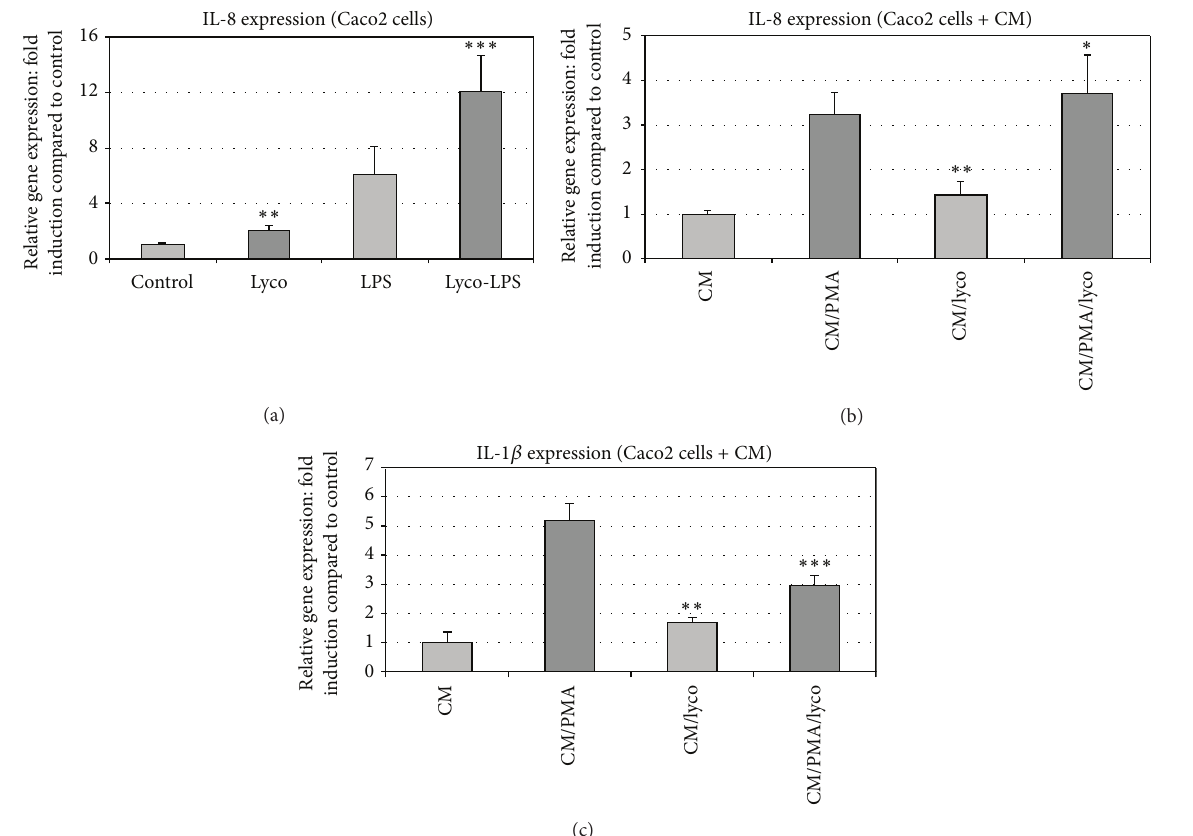
Figure 5: Lycopene-induced modulation of IL-8 and IL-1 gene expression in Caco2 cells. (a) Lycopene induced upregulation of basal and LPS- induced IL-8 gene expression in Caco2 cells. IL-8 gene expression was studied in Caco2 cells treated with LPS. Modulation of this expression was studied in Caco2 cell cultures pretreated for 2 h with or without vectorized lycopene. Then, according to assays, LPS (100 ng/mL) was added for 6 h and mRNA expression was analyzed by RT-qPCR. (b) Lycopene induced no modification of gene expression induced by THP1- derived conditioned medium (CM) in Caco2 cells. THP1 cells were or not exposed to PMA for 2 hours. Then, the cell culture medium was discarded and the cells were extensively washed and a fresh medium without PMA was added and culture was resumed for 6 h. At the end of the culture period, the conditioned media (CM) were collected and then added to Caco2 cell cultures pretreated or not with lycopene for 12h. The final treatment of Caco2 cells with the conditioned medium (CM) was for 6 h and, finally, expression of inflammatory genes was assessed by qRT-PCR. (c) Lycopene downregulates IL-1 gene expression induced by THP1-derived conditioned medium (CM) in Caco2 cells. THP1 cells were or not exposed to PMA for 2 hours. Then, the cell culture medium was discarded and the cells were extensively washed and a fresh medium without PMA was added and culture was resumed for 6h. At the end of the culture period, the conditioned media (CM) were collected and then added to Caco2 cell cultures pretreated or not with lycopene for 12h. The final treatment of Caco2 cells with the conditioned medium (CM) was for 6 h and, finally, expression of inflammatory genes was assessed by qRT-PCR. Values are means ± SD ( 𝑛 = 8 ). Assays treated with lycopene were compared to corresponding assays without lycopene. ∗∗∗ 𝑃 < 0.01 ; ∗∗ 𝑃 < 0.05 ; ∗ , nonsignificantly